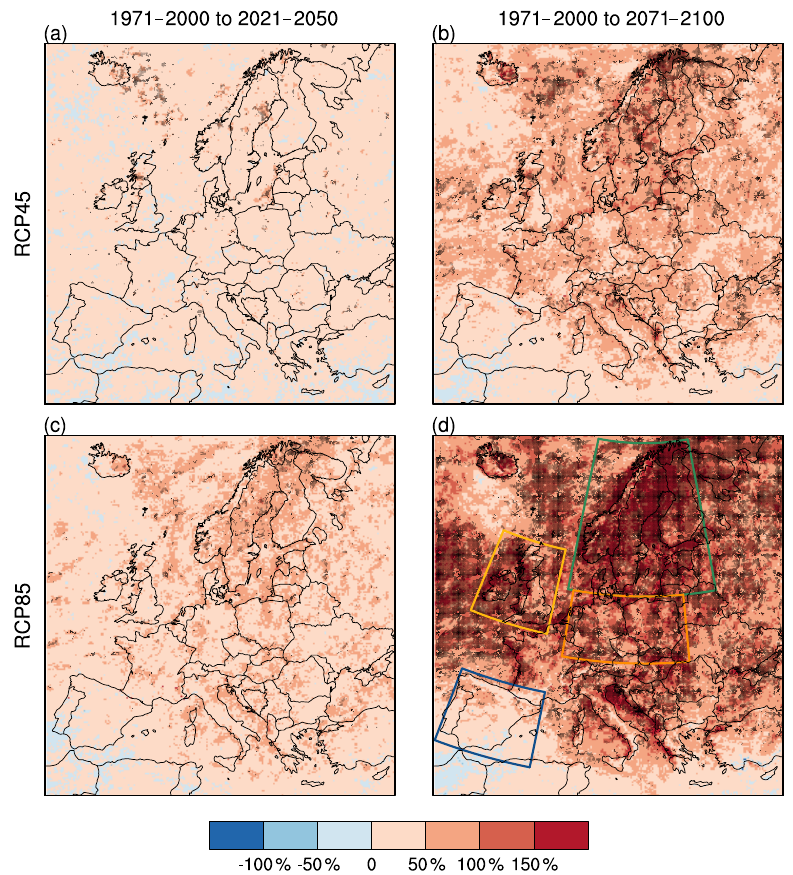
Figure 6. Relative change of probability of events with 10-year return period between the historical simulations (1971–2000) and the scenario simulations ( a 2021–2050 for RCP4.5 scenario, b 2071–2100 for RCP4.5 scenario, c 2021–2050 for RCP8.5 scenario, d 2071–2100 for RCP8.5 scenario). Ensemble mean for daily and multi-day events. Dots denote statistical significance and inter-model consistency. Areas marked in panel (d) are selected for further